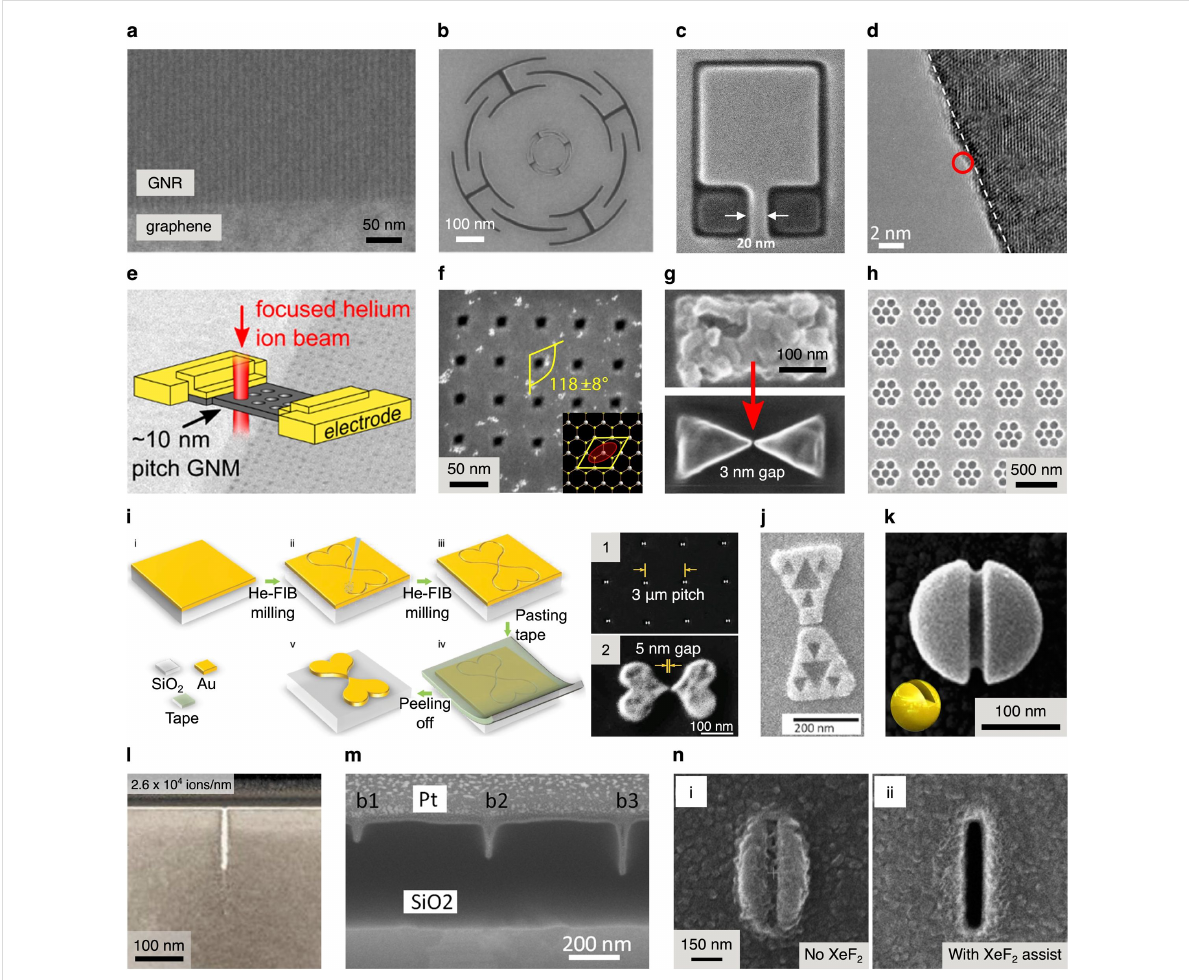
Figure 6: Examples of helium and neon FIB milling. (a) Graphene nanoribbons (GNR) fabricated by helium FIB milling of graphene on SiO 2 /Si. Adapted with permission from [132]. Copyright 2014 American Chemical Society. (b) Nanomechanical diaphragm structure (nested) fabricated by helium FIB milling of a free-standing graphene flake. Adapted with permission from [134]. Copyright 2011 IEEE. (c) Graphene pad structures fabri- cated by helium FIB milling of graphene on SiO 2 , imaged using the HIM: Dark contrast indicates pads that are electrically isolated; a 20 nm wide conductive strip connects the large pad at the top. Adapted from [135]. Copyright 2015 Iberi et al., licensed under a Creative Commons Attribution 4.0 International License, http://creativecommons.org/licenses/by/4.0/. (d) TEM image of a helium FIB-milled edge of a free-standing MoS 2 flake: The dashed line indicates the extent of amorphization; the red circle represents the size of the helium ion beam used. Adapted with permission from [25]. Copyright 2015 American Chemical Society. (e) Free-standing graphene nanomesh (GNM) fabricated by helium FIB milling to demonstrate